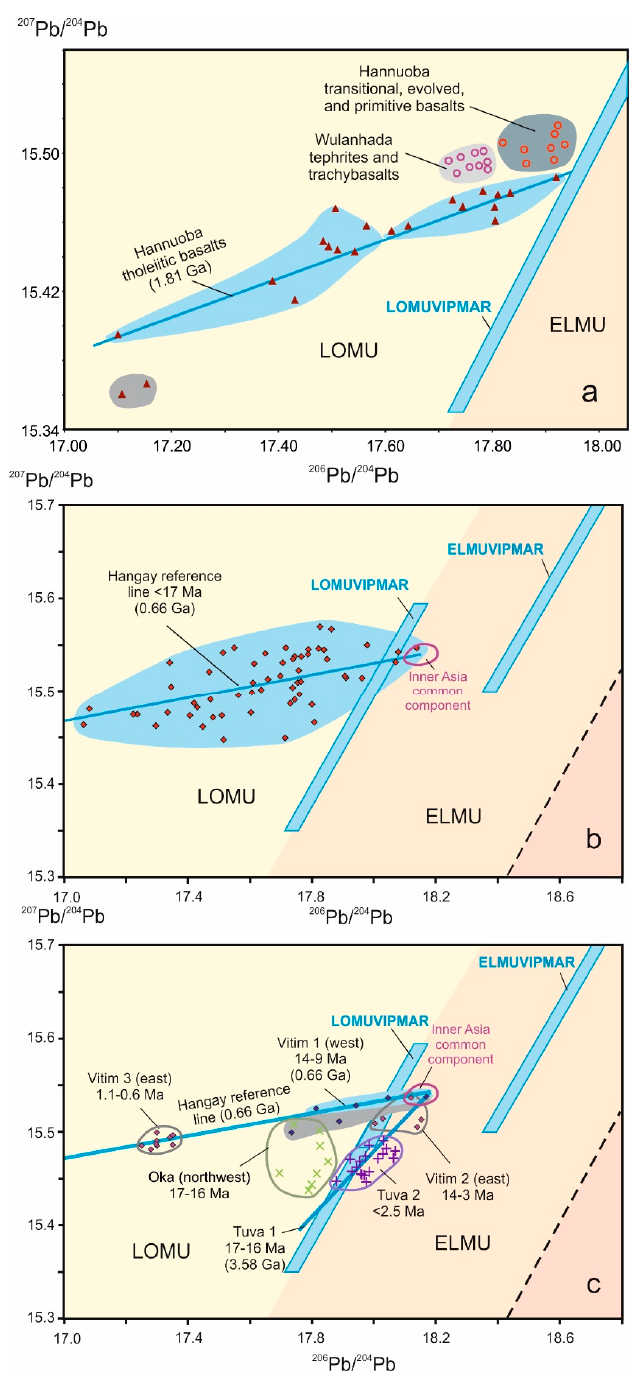
Figure 11. Diagrams of 207 Pb/ 204 Pb versus 206 Pb/ 204 Pb for volcanic rocks from the Hannuoba and Wulanhada volcanic fields ( a ), Hangay volcanic area of the southwestern part of the Baikal rift system ( b ), its northwestern part (Oka, Tuva 1, 2) and northeastern part (Vitim 1 – 3, Udokan 2) ( c ). The LOMUVIPMAR and ELMUVIPMAR compositions, as well as LOMU – ELMU and ELMU limit discriminating lines are shown as in Figure 5. In diagrams b and c, designated is the Inner Asia common component of volcanic rocks. Data used are from [14,38,66,109,110,111] and unpublished data of authors.